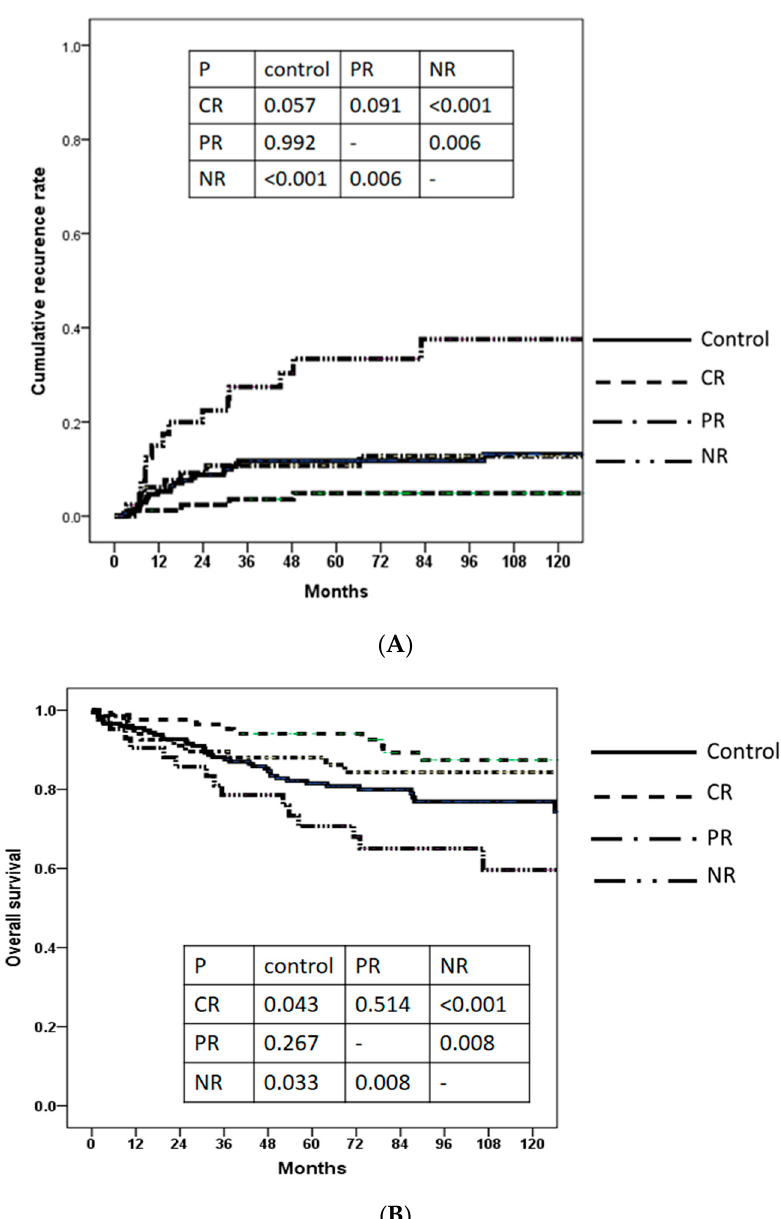
Figure 3. Cumulative recurrence rates ( A ) and overall survival ( B ) of the four groups according to AFP level and AFP response (CR, complete AFP response; PR, partial AFP response; NR, no AFP response). CR group showed the excellent cumulative recurrence rate and survival rate compared with NR group. PR group was comparable to the control.